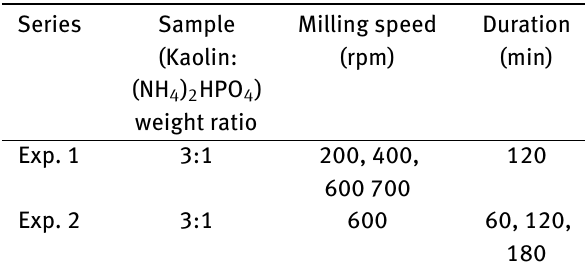
Table 1: The experimental mixture ratios and conditions.